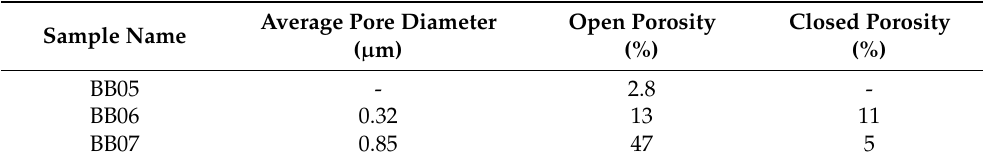
Table 1. Porosity and average pore diameter measured by mercury intrusion porosimeter. The relative standard deviation (RSD) of porosity is